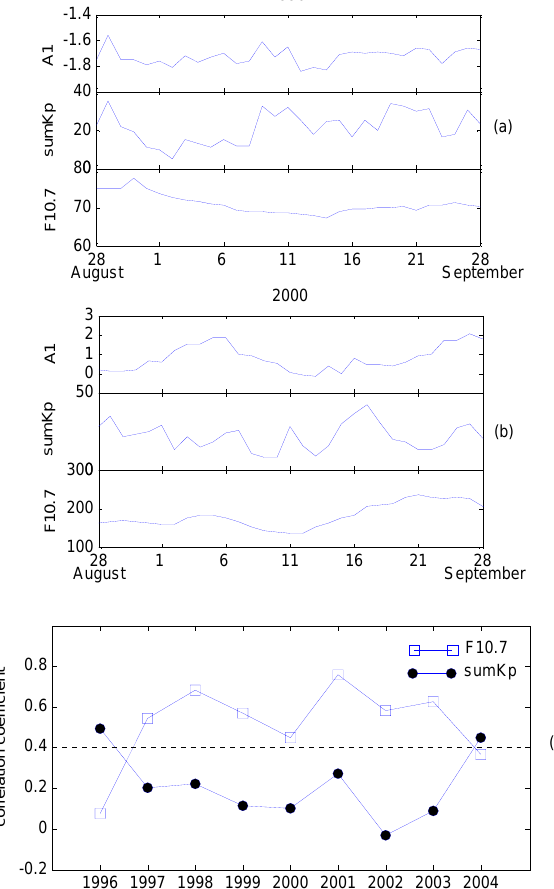
Fig. 9. The variation of A1, sum K p and F 10 . 7 during the period 28 Figure 9. the variation of A 1 , sumKP and F 10.7 during the period 28 August to 28 August to 28 September in the year 1996 (a) , same as (a) but in the September in the year 1996 (a) same as (a) but in the year 2000 (b) yearly correlation year 2000 (b) , yearly correlation coefficient between A1 and F 10 . 7 coefficient between A 1 and F 10.7 (circle) and sumKp (square) (c) (circle) and sum K p (square) (c)